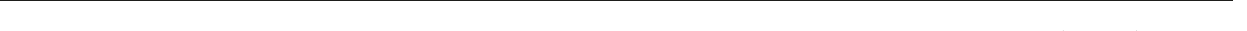
Fig. 3 Transcriptome pro fi ling of macrophage-derived fi broblast-like cells. a Heat map illustrating cluster of transcripts from CD11b + F4/80 + wound macrophages at d3 and d7 post-wounding (PW). A total of 2757 genes were differentially expressed ( p < 0.05, FDR). b Hierarchical cluster analysis of primary murine dermal fi broblast (GEO accession numbers: GSM 106139, GSM 106141, GSM 106149) and murine primary keratinocytes (GEO